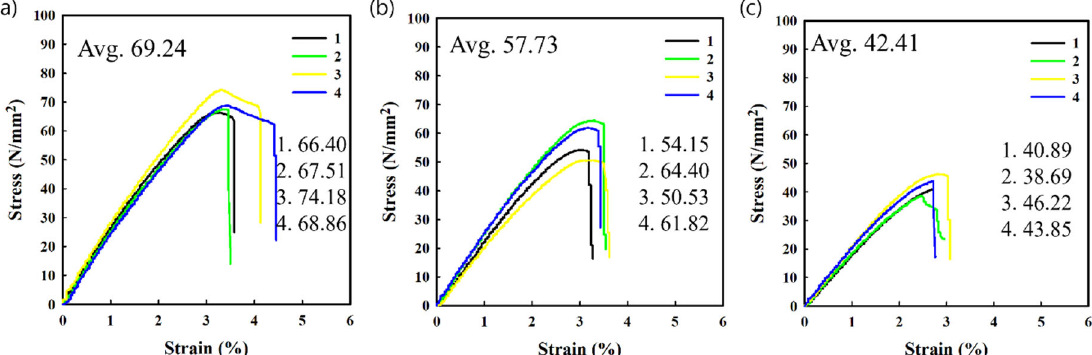
Figure 3. Stress–strain curves for ( a ) pristine, ( b ) one ‐ time recycled, and ( c ) three ‐ time recycled specimens fabricated horizontally.